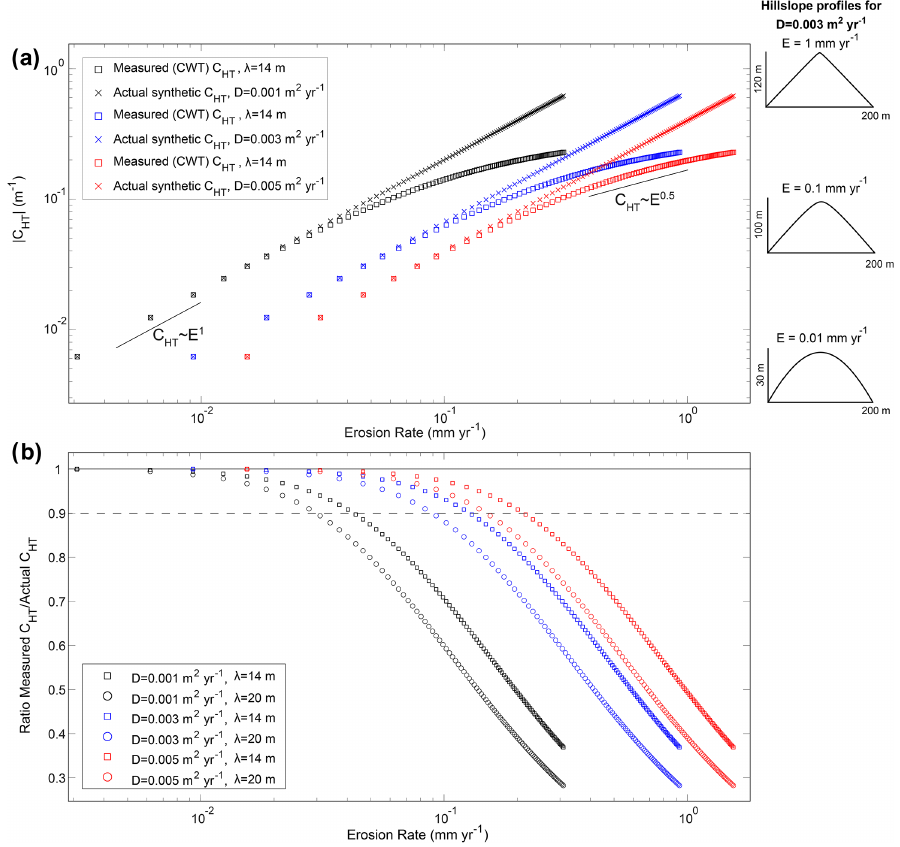
Figure 11. (a) The absolute value of C HT plotted against erosion rate for synthetic hillslopes constructed for E ∗ = 1–100, corresponding to = 0 . 5). Crosses correspond with the actual erosion rates of ∼ 0.01–1mmyr − 1 for diffusivities ranging from D = 0 . 001–0.005m 2 yr − 1 ( ρ s ρ r C HT for each synthetic hillslope constructed for a given E ∗ . Squares are C HT-W , using the L07 λ definition. In this case λ = 14m. Note the linear relationship between C HT and erosion rate at small erosion rates, in agreement with Eq. (1). As erosion rate increases, the relationship between measured C HT and E is no longer linear but could be potentially expressed as a power law. The erosion rate at which this deviation occurs is visualized in panel (b) . An example square root relationship is plotted at these erosion rates for reference (Gabet et al., 2021). Note example synthetic hillslopes profiles (for D = 0 . 003m 2 yr − 1 ) spanning the range of erosion rates on right side of panel ( y axes of profiles differ). (b) Ratio of measured C HT and the actual model-defined C HT for synthetic hillslopes constructed for E ∗ = 1–100 using a range of diffusivities ( D = 0 . 001–0.005m 2 yr − 1 , L H = 100m) and measured with λ = 14m (same as panel a ) and λ = 20m. For each case, the measured C HT deviates from the known value as erosion rate increases. The erosion rate at which this deviation occurs depends on diffusivity and smoothing scale, λ . Dashed line corresponds to where C HT is underestimated from the true value by